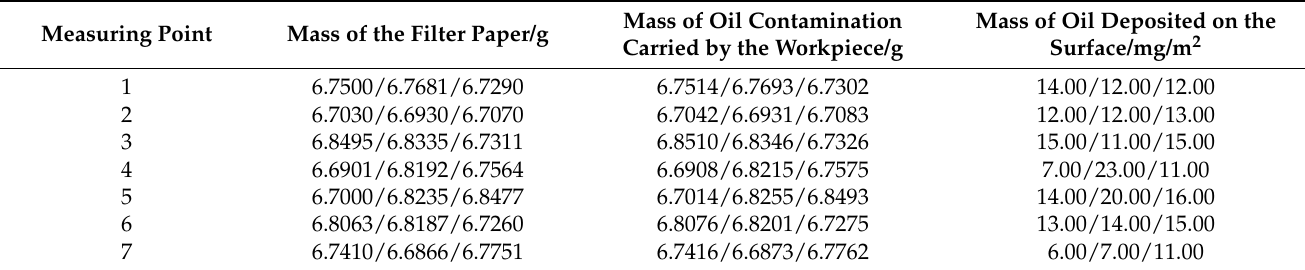
Table 1. On-site measurement results of the three